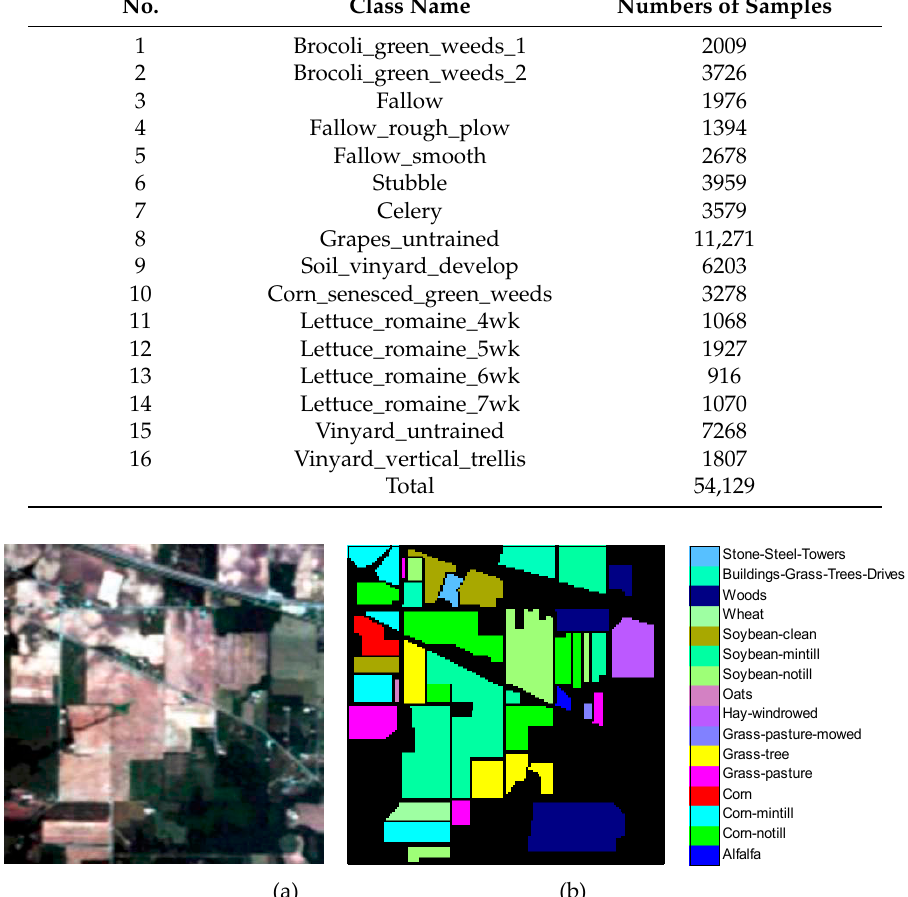
Figure 4. ( a ) False-color image of the Indian Pines data, ( b ) Ground truth of the Indian Pines data. Figure 4. (a) False-color image of the Indian Pines data, (b) Ground truth of the Indian Pines data. Table 2. Land cover classes and numbers of samples in the Pavia University data set.